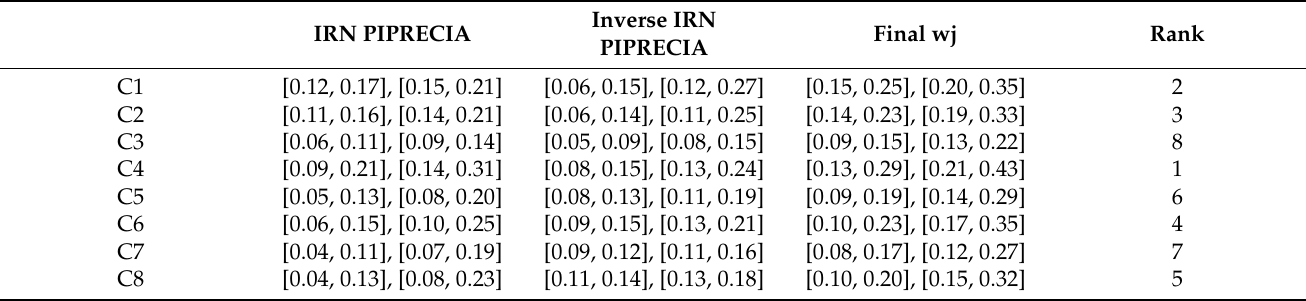
Table 5. Results obtained by applying the IRN PIPRECIA